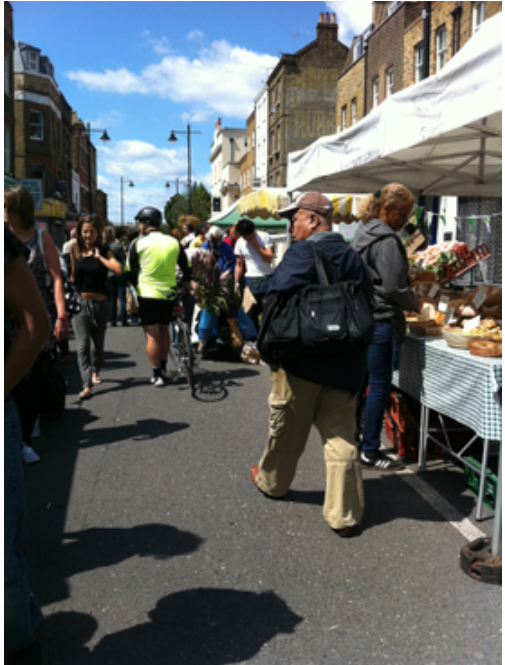
Figure 4. Urban environment with people (Study 2).